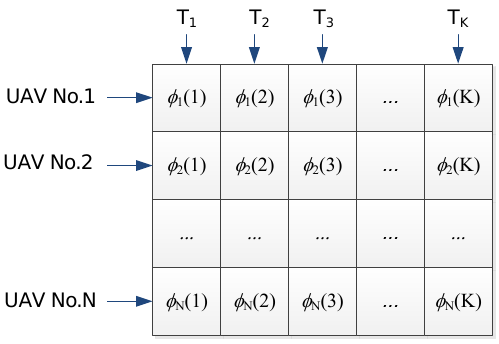
Figure 4. The coding scheme of the CRO algorithm.